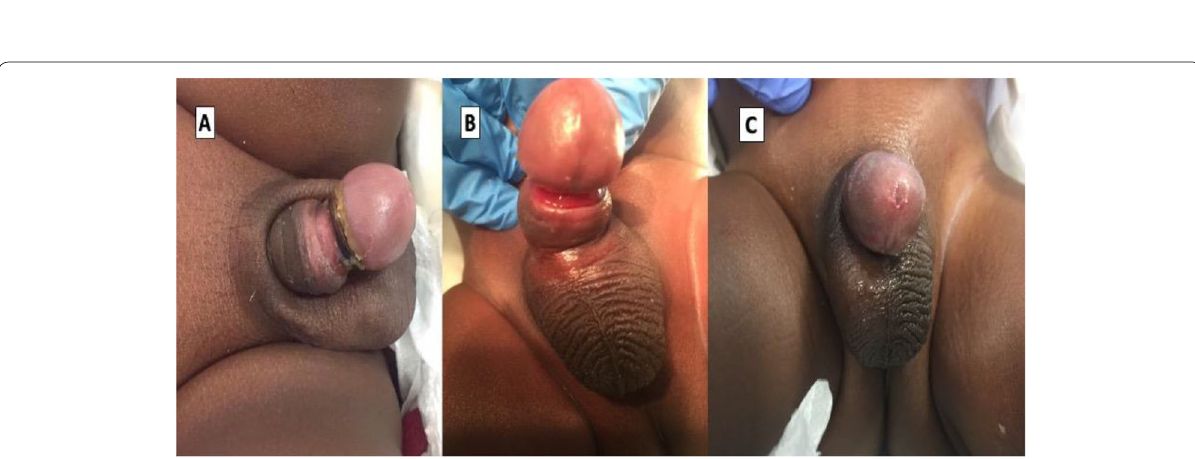
Fig. 2 Five-month-old child: A 2 months post-circumcision show a proximal migration of Plastibell with swelling in the glans penis, B immediately after Plastibell removal, and C 2 weeks after Plastibell removal with a good cosmetic